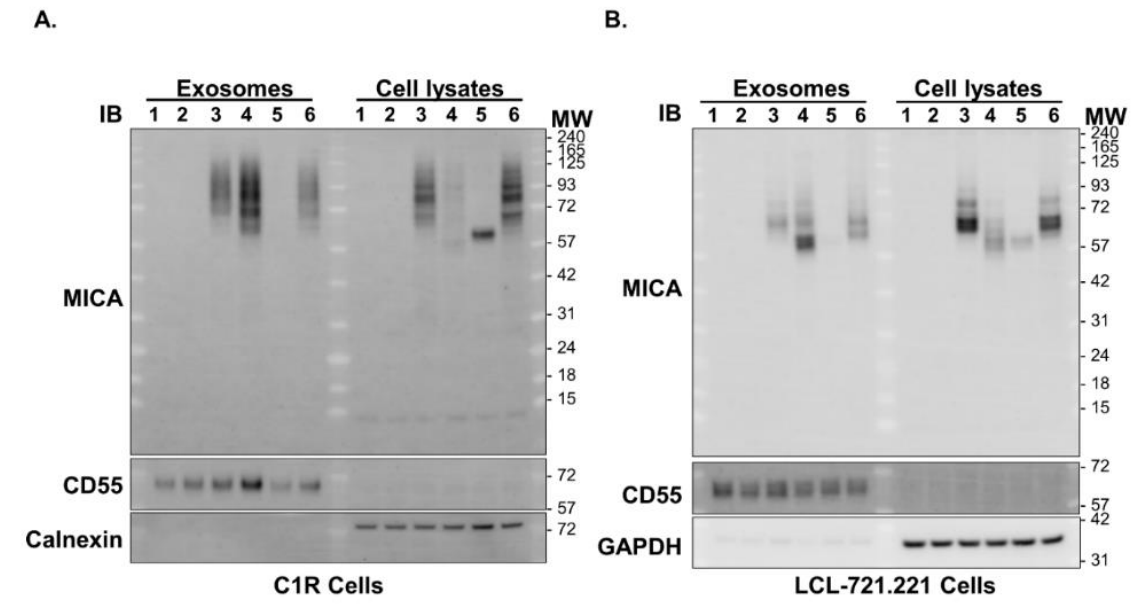
Figure 3. Western blot analyses of MICA from exosomes and cell lysates. ( A ) Ultracentrifugation of culture supernatants of C1R parental cells (Lane 1), C1R cells stably expressing empty vector (Lane 2), MICA*002 (Lane 3), MICA*008 (Lane 4), MICA*010 (Lane 5) and MICA*019 (Lane 6) was used to obtain exosomes in ultracentrifugation pellets. The parental C1R cells (Lane 1), C1R cells stably expressing empty vector (Lane 2), MICA*002 (Lane 3), MICA*008 (Lane 4), MICA*010 (Lane 5) and MICA*019 (Lane 6) were lysed in lysis buffer to generate total cell lysates. Exosomes and total cell lysates were subjected to western blot analysis, as described in Materials and Methods. CD55 was used as a loading control to normalize the expression of MICA in exosomes and GAPDH as a loading control to normalize the expression of MICA in total cell lysates. C1R cells expressing MICA*008 (Lane 4) produced the highest amount of exosomal MICA compared to cells expressing MICA*002 (Lane 3) and MICA*019 (Lane 6), while no exosomal MICA was produced from MICA*010 (Lane 5) cells. Lysates of MICA*002 (Lane 3) and MICA*019 (Lane 6) cells contained more intracellular MICA than MICA*008 (Lane 4) and MICA*010 (Lane 5) cells. ( B ) Western blot analyses of exosomes and cell lysates from parental LCL-721.221 cells (Lane 1) and LCL-721.221cells stably expressing vector control (Lane 2), MICA*002 (Lane 3), MICA*008 (Lane 4), MICA*010 (Lane 5) and MICA*019 (Lane 6) alleles. Similar results were obtained as in C1R cells. All experiments were repeated at least three times and representative data are shown.